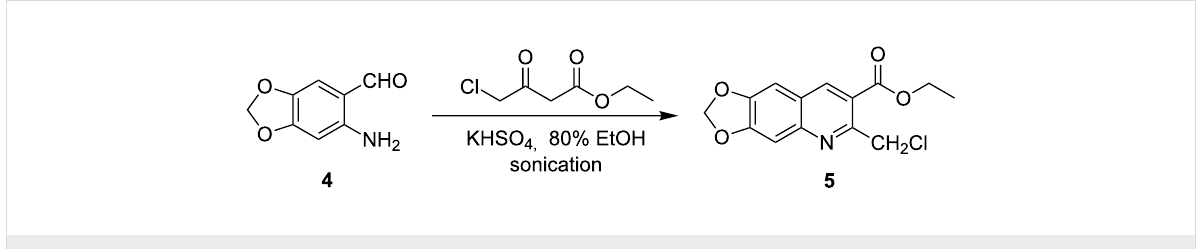
Scheme 1: Synthesis of ethyl 2-chloromethyl-6,7-methylenedioxyquinoline-3-carboxylate ( 5